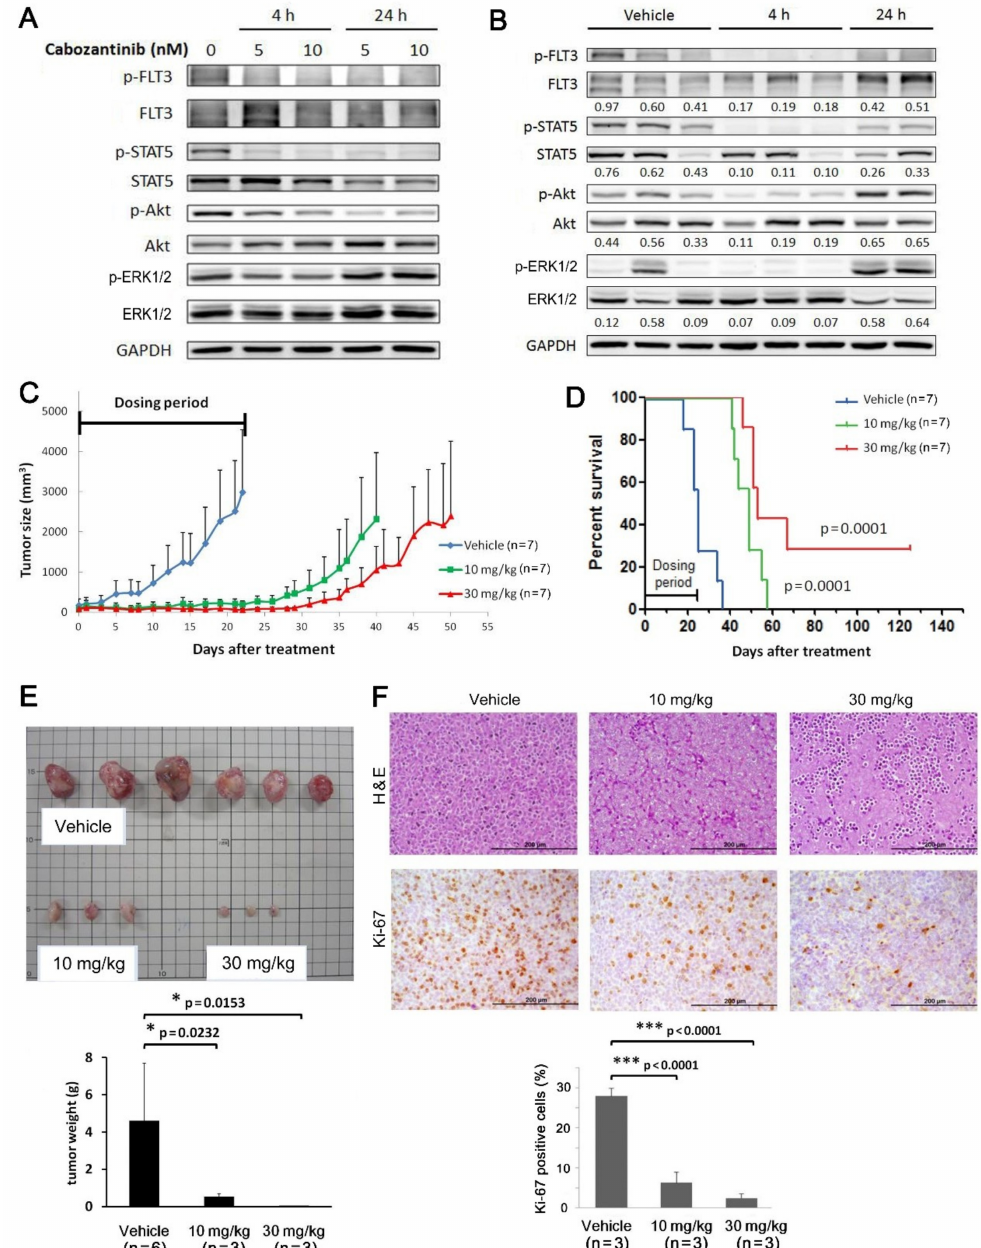
Figure 7. Cabozantinib inhibits FLT3 -ITD signaling in MV4-11-R cells and growth of MV4-11-R-derived tumors. Kinase phosphorylation of the FLT3 -ITD signaling pathway in cultured MV4-11-R cells was evaluated by Western blot analysis ( A ). MV4-11-R tumor xenografts were grown in nude mice; when tumor sizes reached 100–200 mm 3 , mice were then given 30 mg/kg of cabozantinib-malate in a single dose. Mice were sacrificed after 4 h or 24 h, and protein extracts were prepared from the tumor tissues and analyzed by Western blotting ( B ). To assess tumor growth, mice with MV4-11-R xenograft tumors reaching 100–200 mm 3 were randomly given vehicle, 10 mg/kg, or 30 mg/kg cabozantinib-malate daily in four five-day courses (days 1–5, 7–11, 13–17, and 19–23). Tumor volumes were measured every 1–2 days ( C ), and Kaplan–Meier survival curves of the different mice groups were plotted against the number of days after treatment ( D ). Multiple tumors from each treatment group were obtained, weighed ( E ), stained with hematoxylin and eosin (H&E) or Ki-67 antibodies, and quantified for the number of Ki-67-positive cells ( F ). Quantification data represents the mean ± SD from three independent experiments. *, p < 0.05; **, p < 0.01; ***, p < 0.001. Scale bars = 200 µ